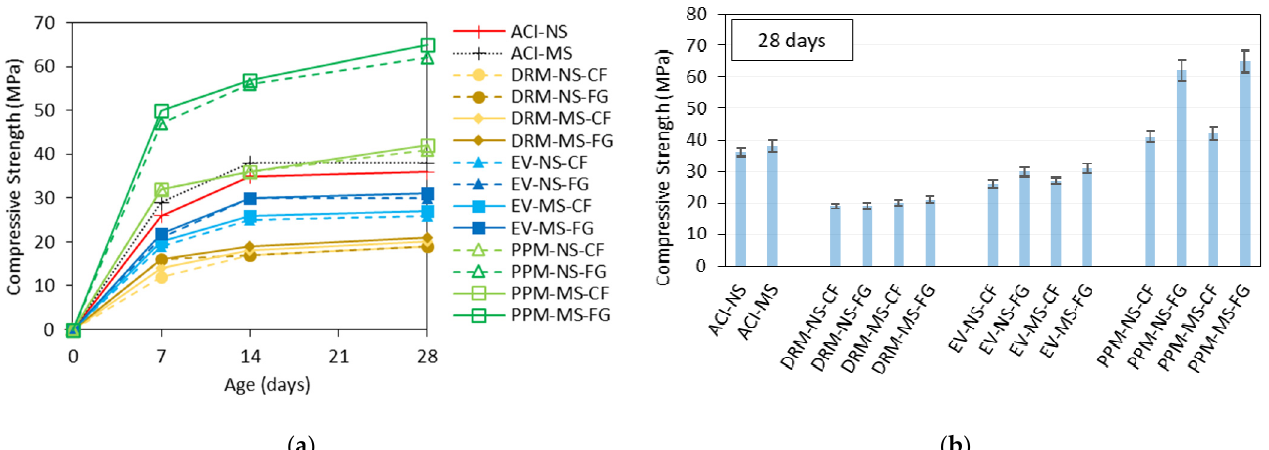
Figure 7. Compressive strength for all mixtures appraised: ( a ) over time and ( b ) at 28 days with the error bars.